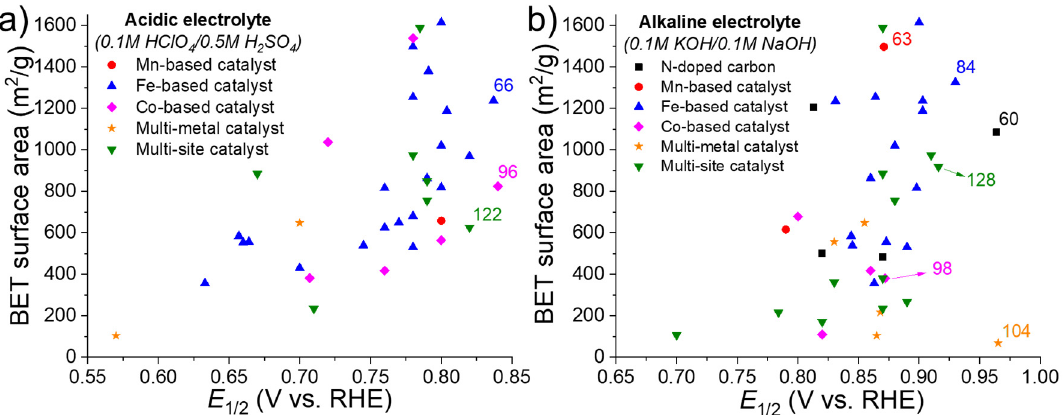
Figure 18. Graphic of Brunauer-Emmet-Teller (BET) surface area vs. E 1 / 2 for the di ff erent categories of MOF-based electrocatalysts investigated in ( a ) acidic and ( b ) alkaline media. The best electrocatalysts in terms of E 1 / 2 for each category are identified with the corresponding reference number. Note that some works are not represented because they do not report BET surface area, use an electrolyte that is too exotic to be compared with other works (e.g., phosphate bu ff er solution), or E 1 / 2 is reported vs. another